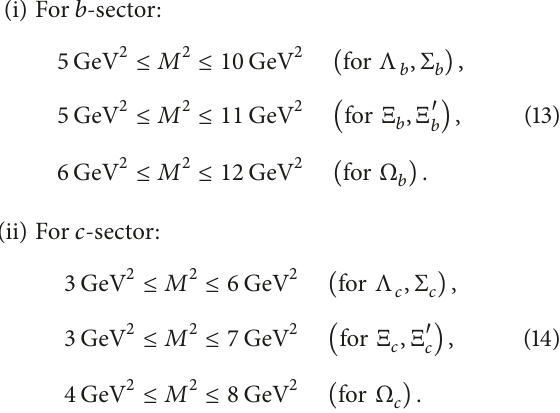
Figure 2: The same as in Figure 1, but for Ξ 󸀠+ 𝑐 → Σ ++ 𝑐 𝐾 −